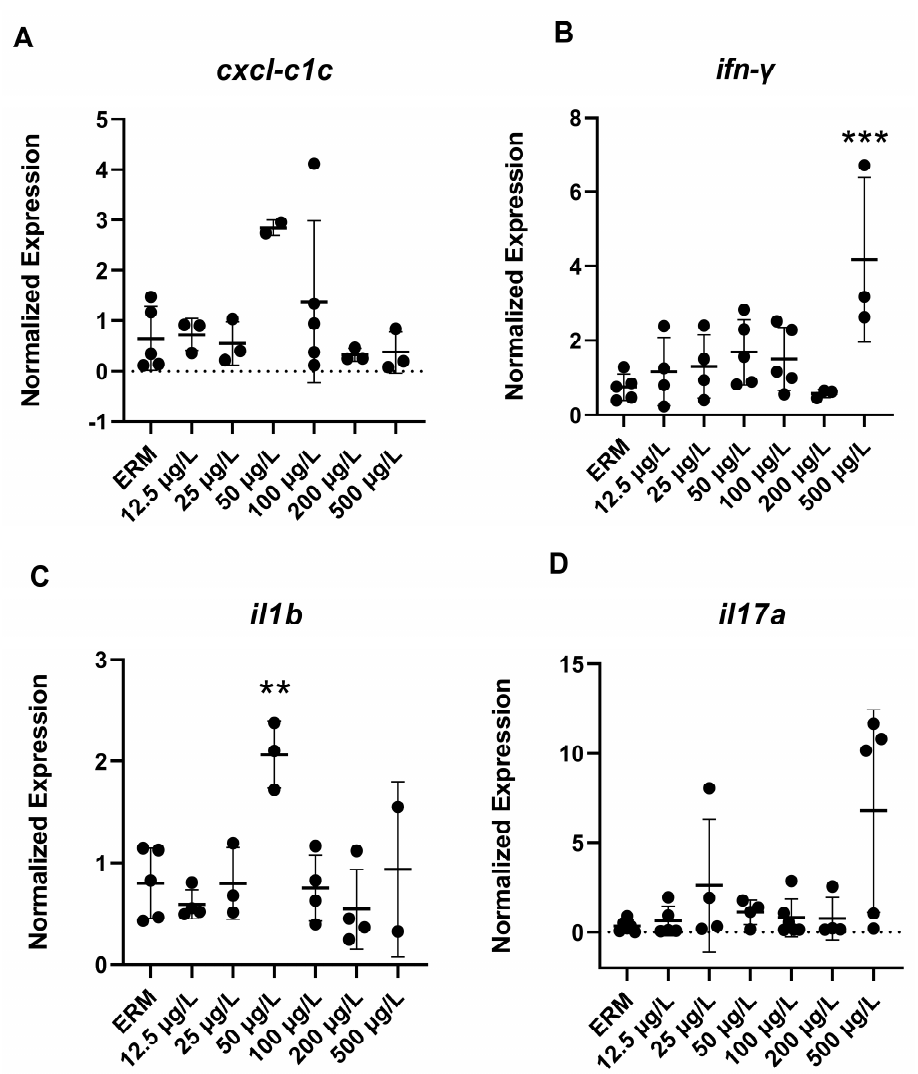
Figure 3. Transcript levels of immune system: ( A ) chemokine cxcl-c1c ; ( B ) interferon gamma, ifn- γ ; ( C ) Interleukin-1beta, il-1b ; ( D ) Interleukin-17A, il-17 in 7 dpf zebrafish larvae exposed to sulfamethoxazole. Data are represented as mean ( ± SD). One-way ANOVA followed by Dunnett’s post-hoc test, ** p ≤ 0.01, *** p ≤ 0.001, n = 3–5 biological replicates/treatment.